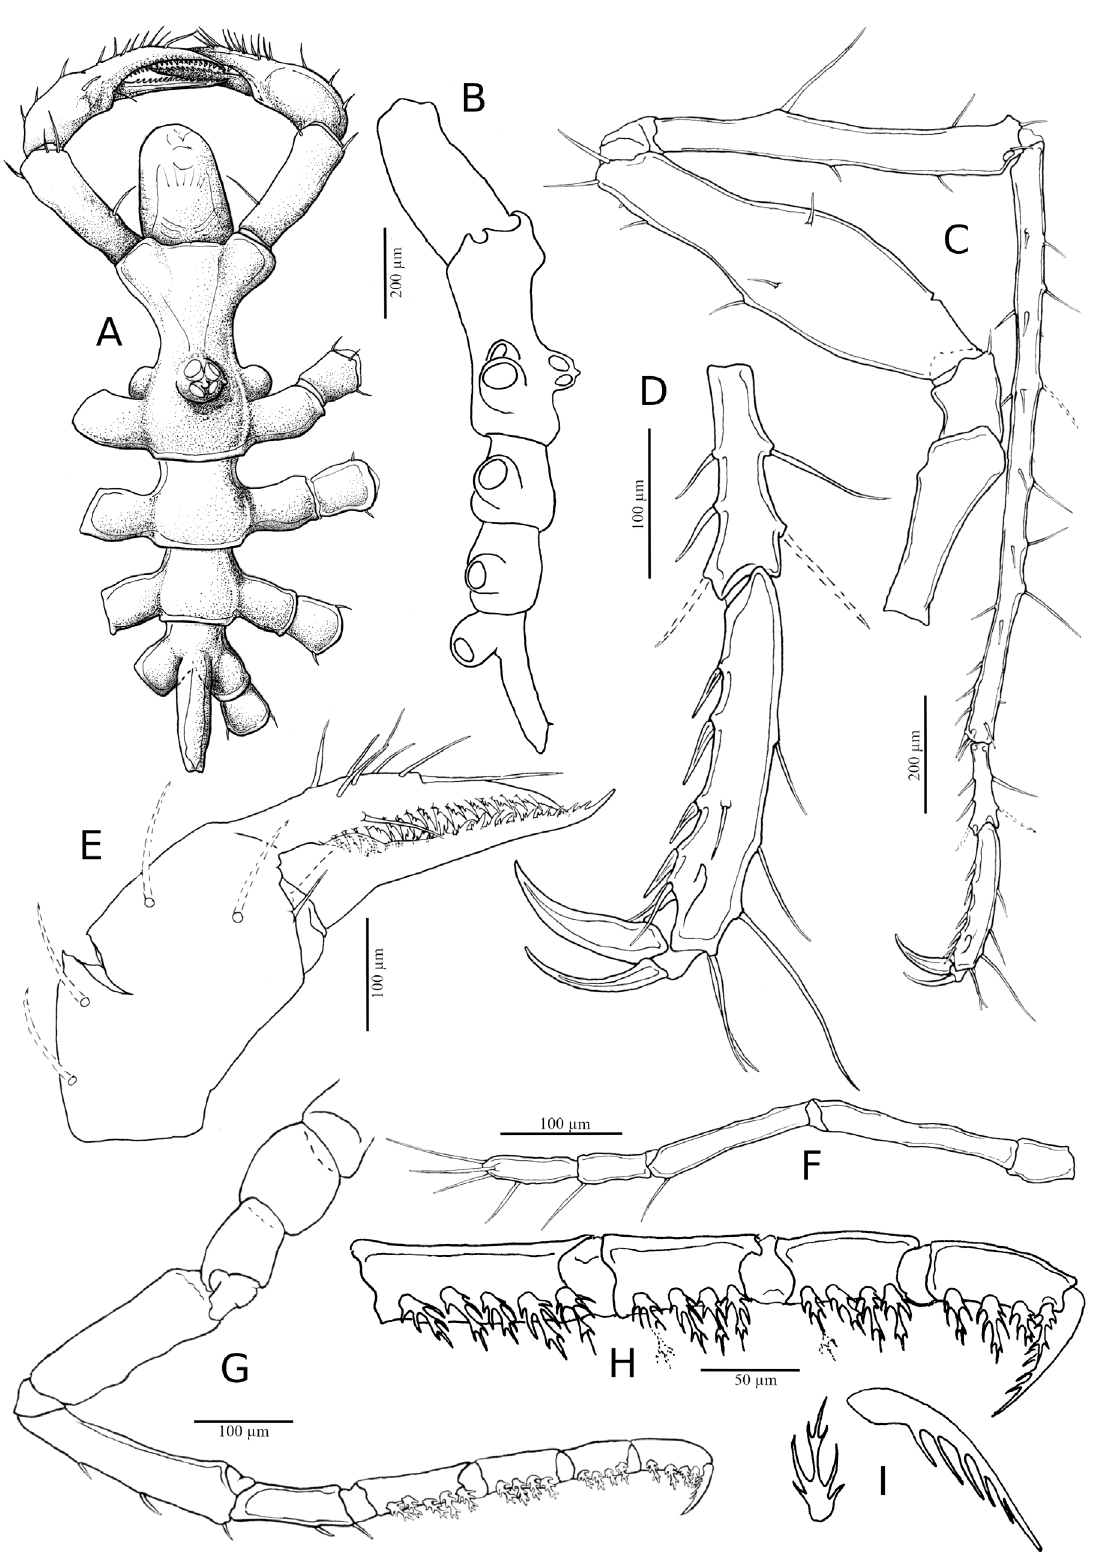
Fig. 15. Nymphon timons sp. nov., holotype, ♀, MNHN-IU-2016-844. A . Body, dorsal view. B . Body, lateral view (same scale as A). C . Fourth leg. D . Tarsus and propodus of fourth leg. E . Chela. F . Palp. G . Oviger. H . Oviger strigilis. I . Compound denticle and terminal claw of